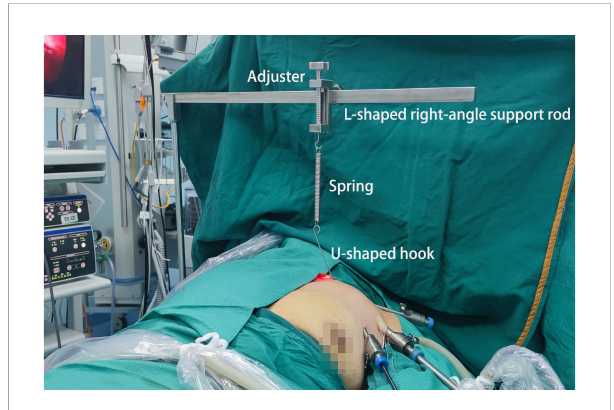
FIGURE 3 The usage scenario of the elastic stretch cavity